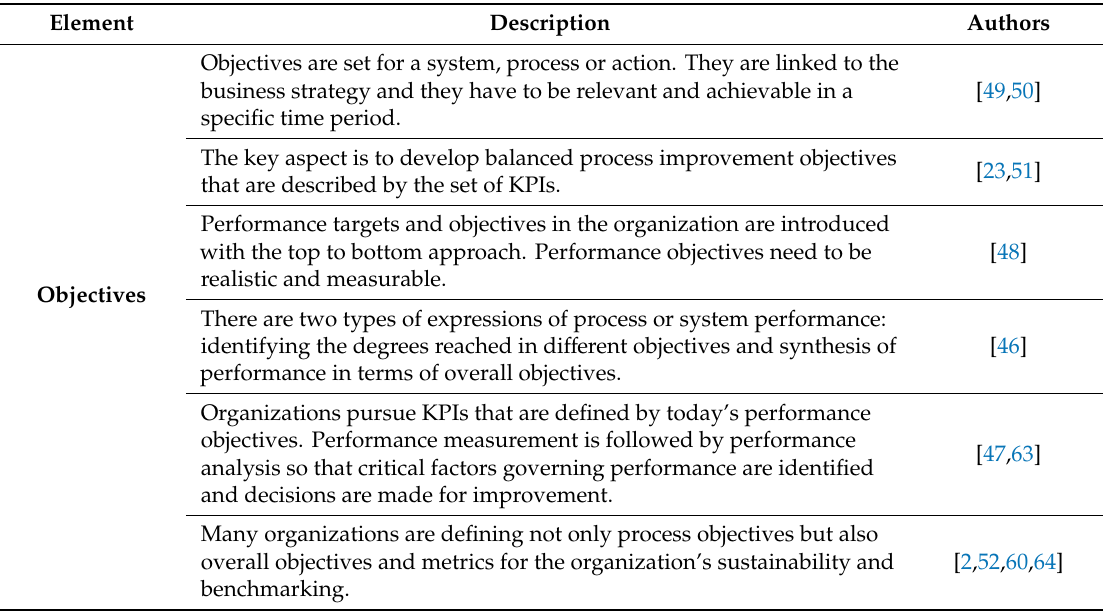
Table 6. The term, objectives, used in relation to organizational performance.